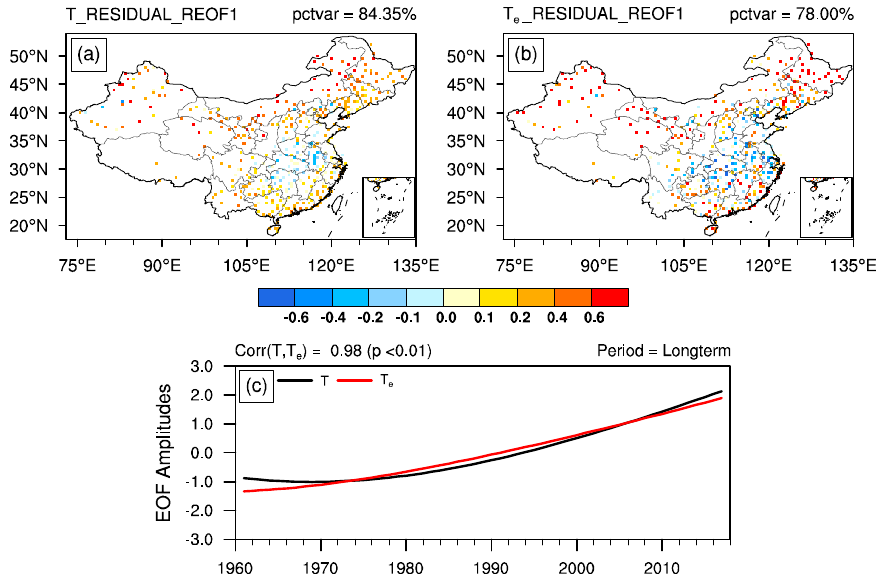
Figure 6. The first REOF modes of the residual component of summertime T ( a ) and T e ( b ) in China, and the corresponding principal component ( c ). Note that the “pctvar” in the figure means percent variance; “Corr” means correlation coefficient between T and T e ; Black (Red) line represents the principal component of T ( T e ).